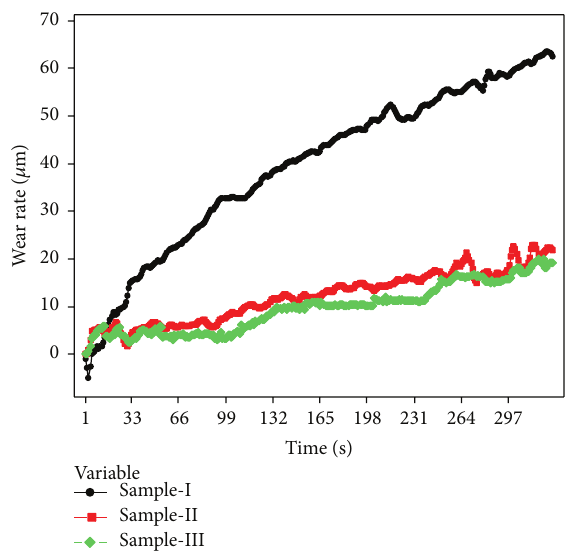
Figure 9: Variation of wear rate of the samples with time after running 1000m at 1.57m/s sliding speed and at an applied load of 9.81